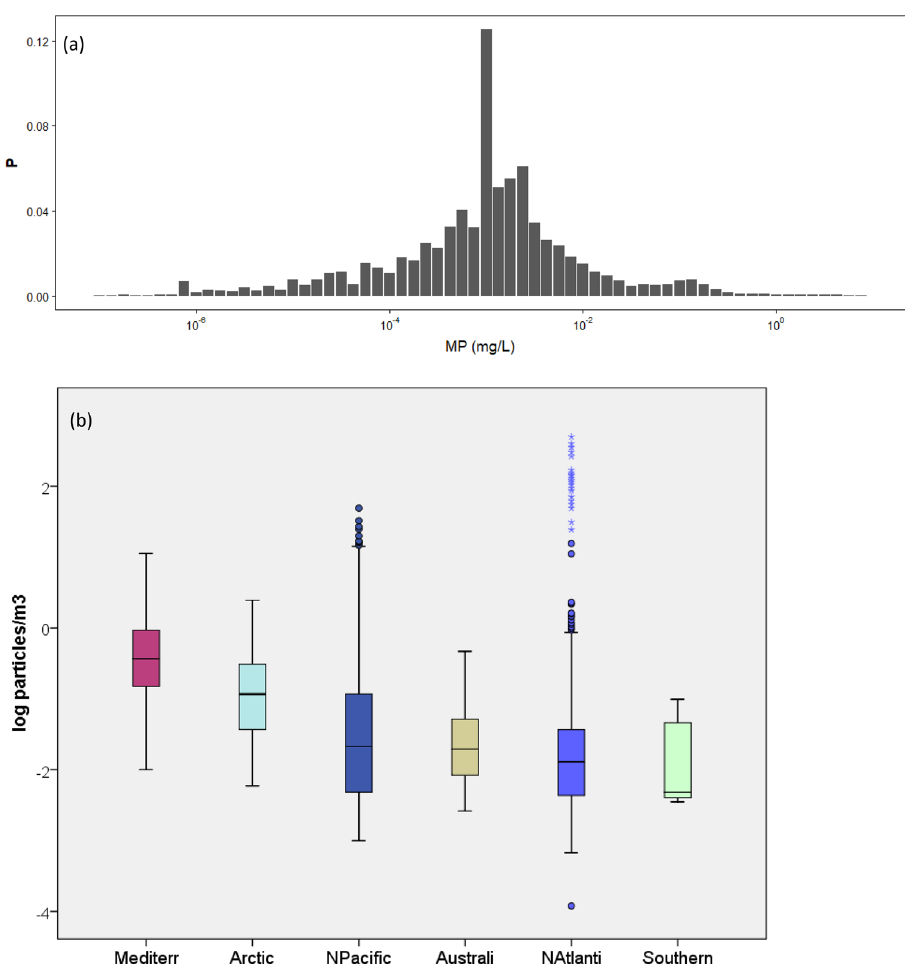
Figure 1. ( a ) Probability (P) distribution of microplastic density (MP, mg/L in log scale) in seawater from all data reviewed. The 0 mg/L values were excluded. ( b ) MP density (log particles/m 3 ) in the different oceans sampled ordered from left to right by decreasing median. Horizontal line: median; box boundaries: 25th and 75th percentiles; bars: range of observed values; dots and asterisks: potential